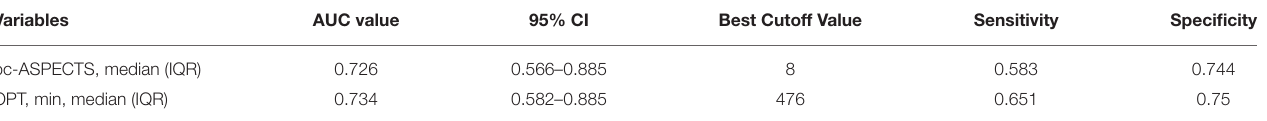
AUC indicates area under the curve; mRS, modified Rankin Scale; pc-ASPECTS, the posterior circulation Acute Stroke Prognosis Early CT Score; OPT, onset to puncture time; IQR, interquartile range; 95% CI, 95% Confidence Interval.